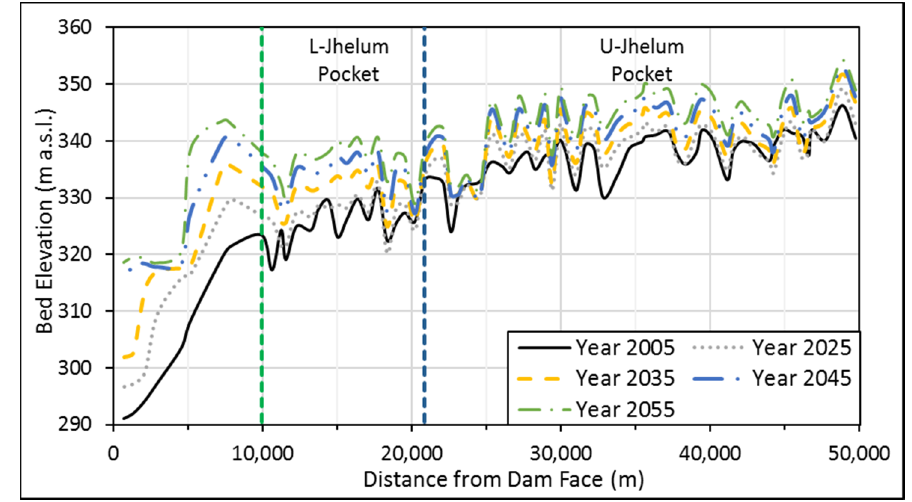
Figure 14. Bed profile of the deposited sediment for S1-45 scenario.